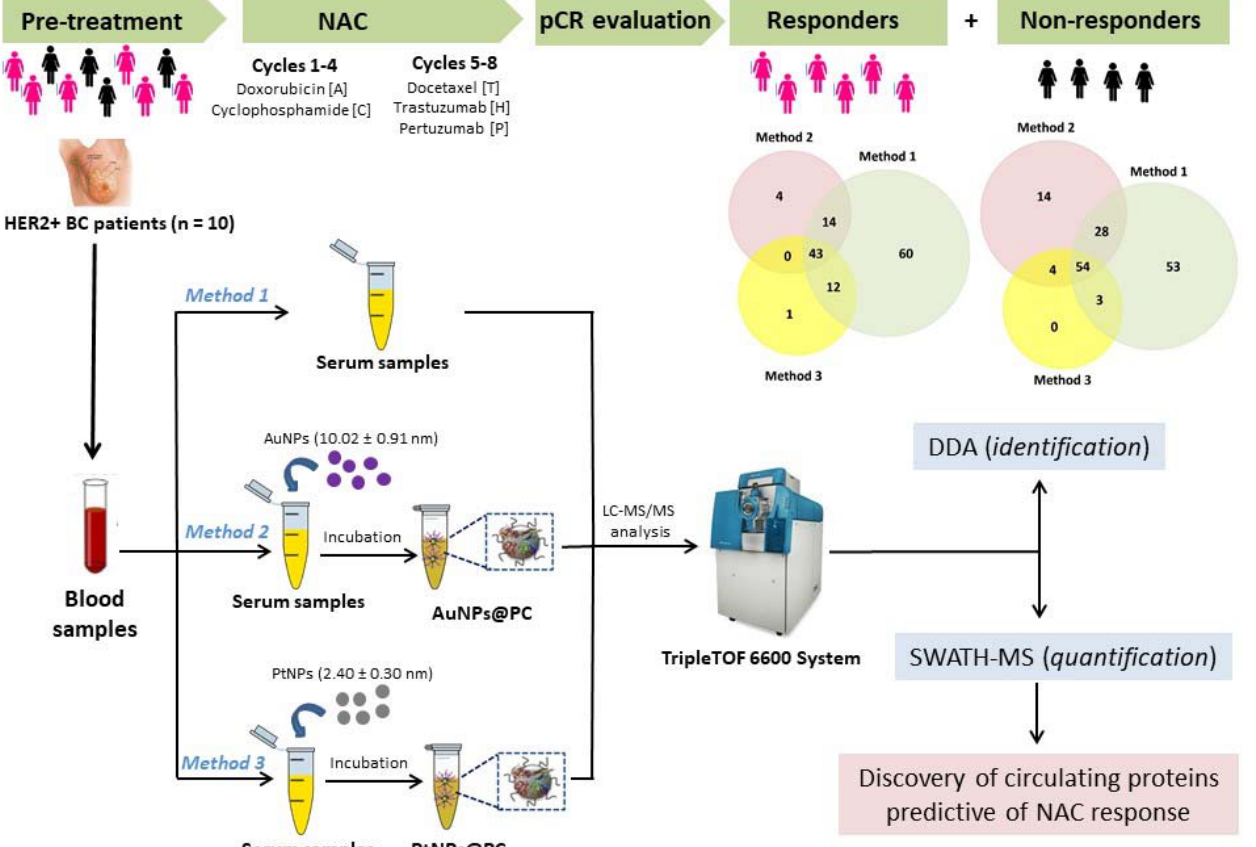
Figure 1. A schematic diagram of experimental workflow.